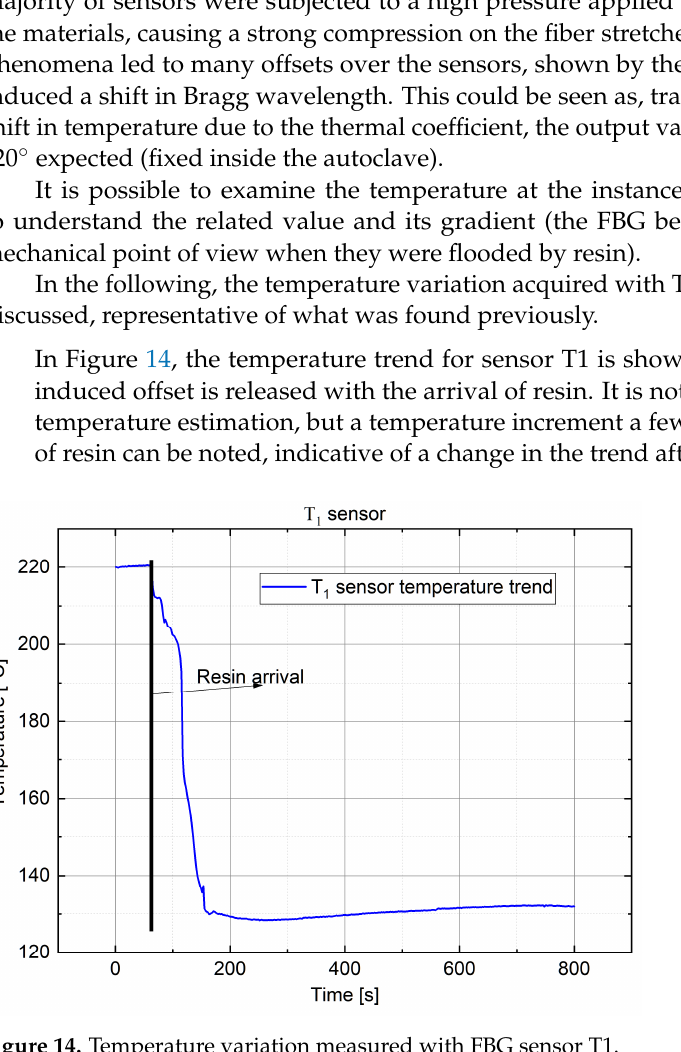
Figure 15. Temperature variation measured with FBG sensor T4 with an extrapolation to obtain the temperature value at the arrival of resin. The information provided by sensor T4 allowed us to determine that the resin inside Ω  was at a higher temperature than the pre-heated one (90 °C) and, moreover, it tended to rapidly increase to the chamber temperature (118–120 °C). Furthermore, the sentence above implies that the resin came into the medium and was infused at a temperature close to 115 °C, aligned with the chamber temperature externally imposed. These considerations are confirmed by other sensors that, independently from the starting offset, did not give significative transients when in contact with the resin.